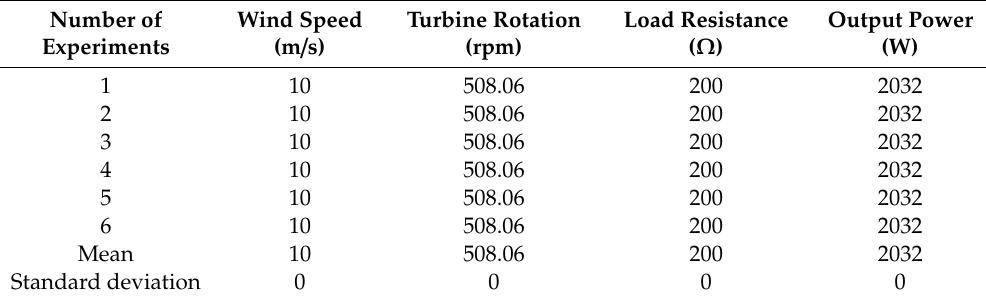
Table 6. Results of the PO algorithm validity